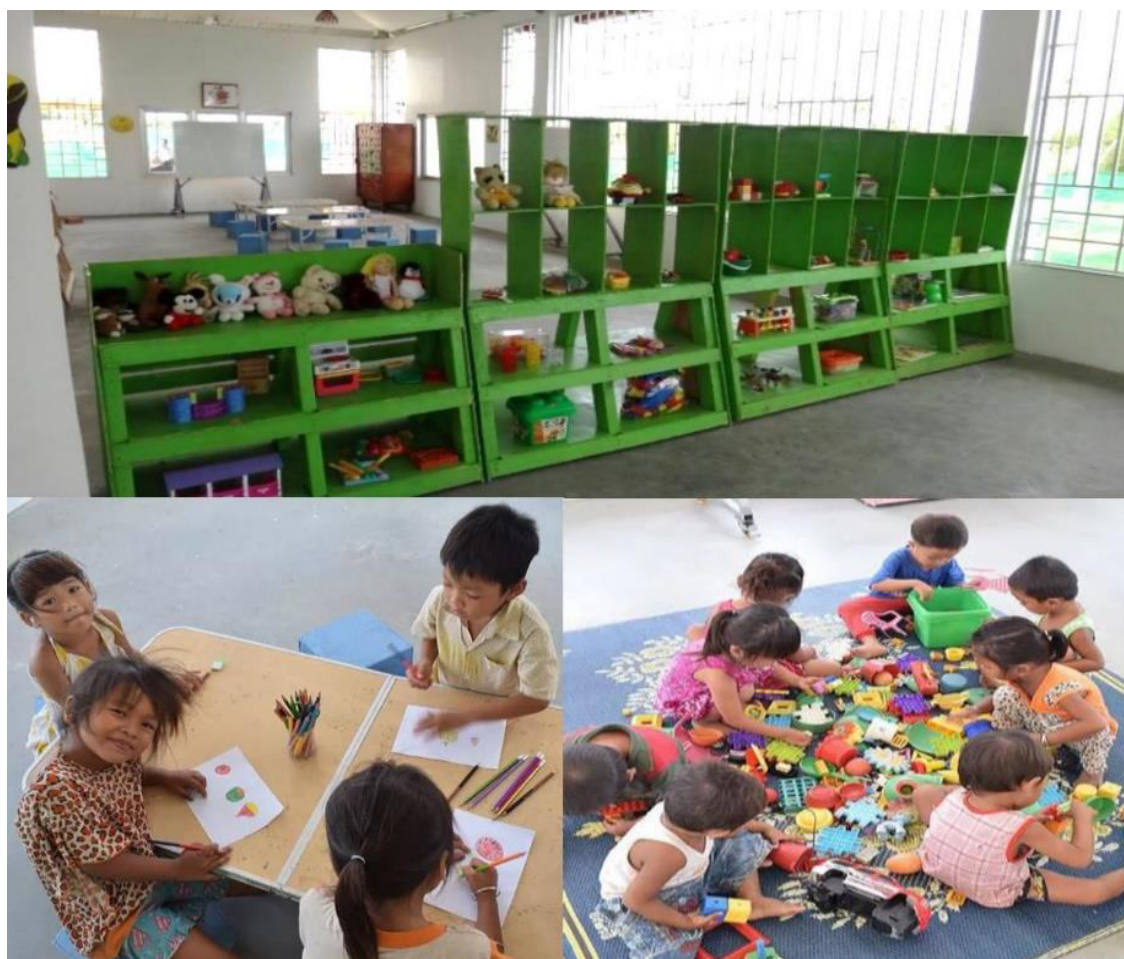
Figure 5. Childcare center and facilities. Source: Smile Village management.